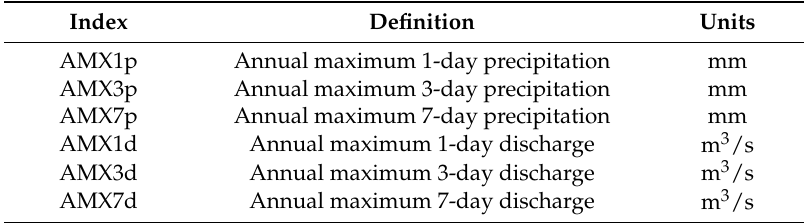
Table 3. Definition of extreme precipitation indices in this